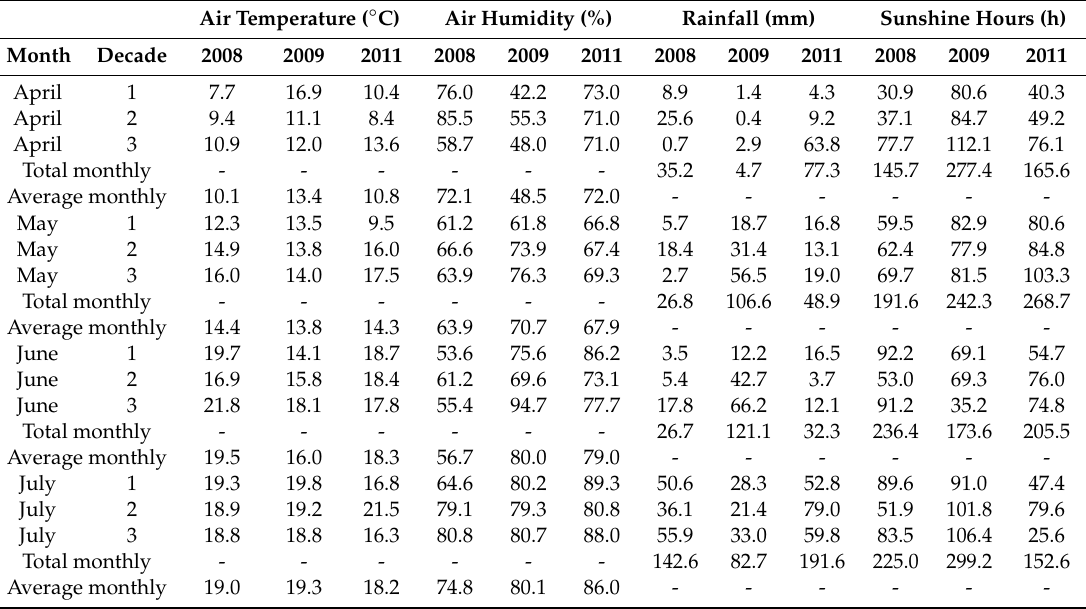
Table 3. Meteorological data for the subsequent years of field cultivation of